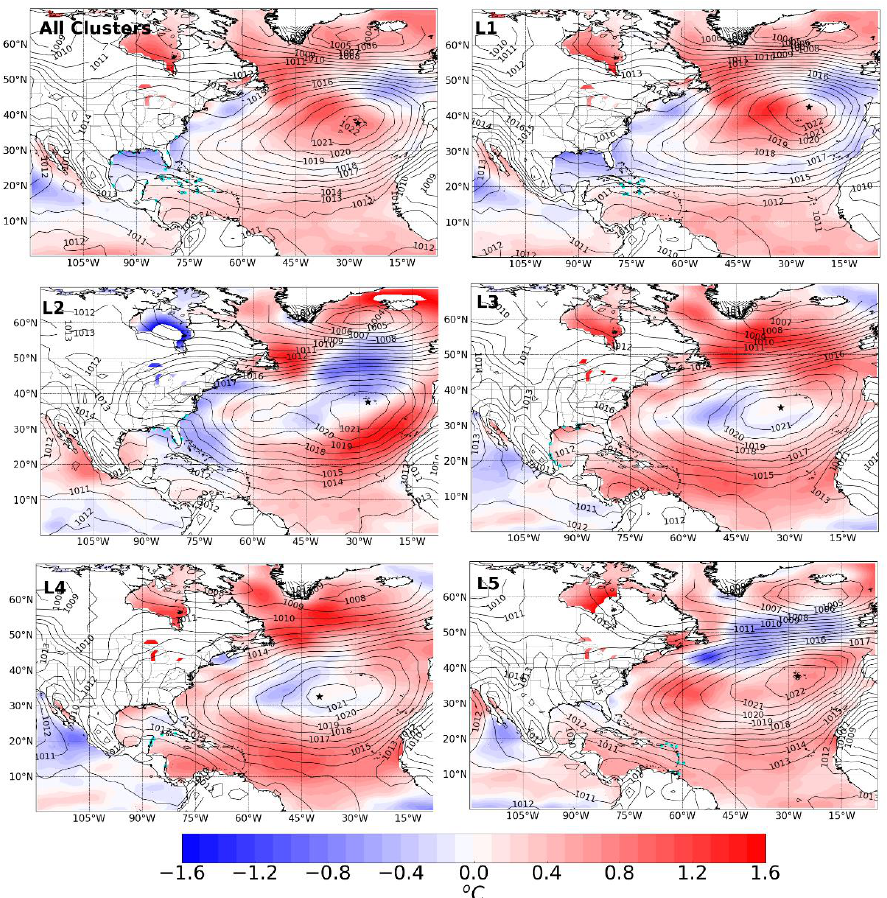
Figure 9. Composite of NASH position and structure (contour) for months with landfalling events in the year of maximum landfalling frequency for the whole basin and each region. The shaded plots represent the mean SST anomalies for the same months and years of NASH position and structure composite. The black star point represents the NASH center, and cyan points represent landfalling events. “All clusters” represents the whole basin and L N (N = 1, 2, 3, 4, 5) represents each landfalling cluster.